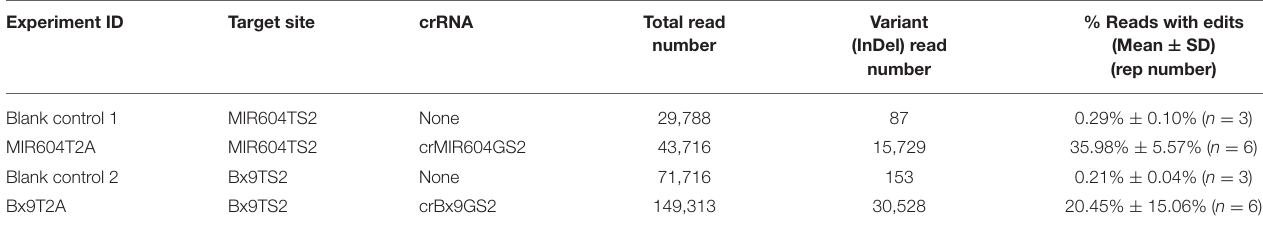
TABLE 2 | Transient editing of maize chromosomal target sequence by AsCas12a-Ultra RNP complexes delivered via PEG-mediated protoplast transfection. Experiment